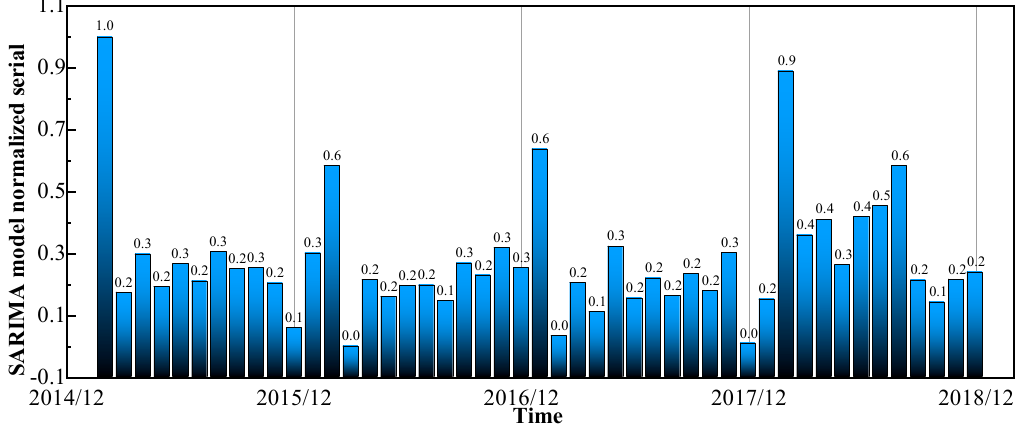
Figure 5. The normalized results of the residual sequence of the SARIMA model.